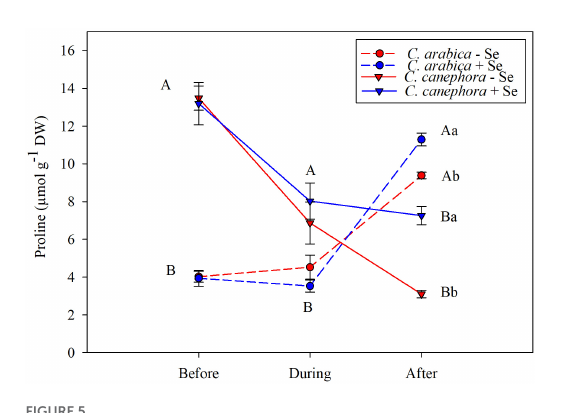
FIGURE5 Effects of Se foliar application and temperature conditions on Pro content in leaves of C. arabica and C. canephora during the rewarming. Mean values followed by different lowercase letters within Se supply conditions (with selenium and without Se) in each genotype are significantly different ( p < 0.05, n = 5) by Tukey multiple comparison tests as well as different uppercase letters that indicate significant differences in species ( C. arabica and C. canephora ). Vertical bars represent the standard error.